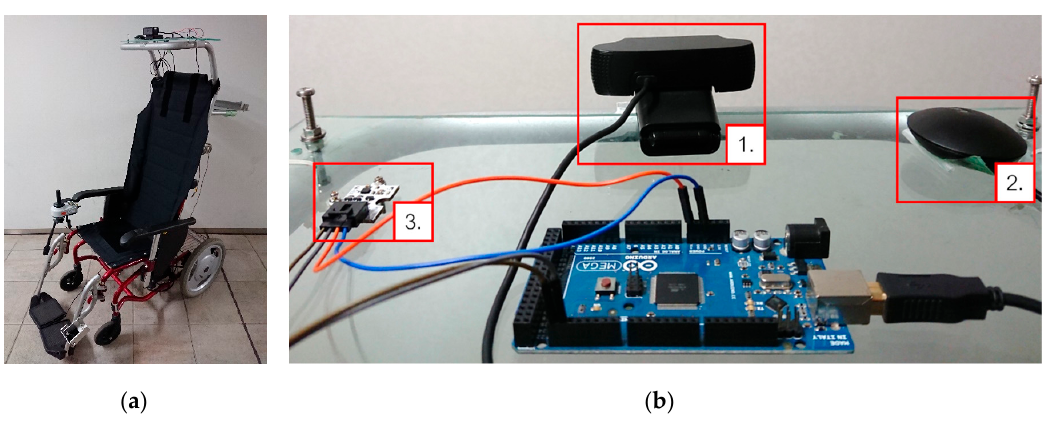
Figure 5. Wheelchair robot equipped with sensors for data gathering: ( a ) overall view of the wheelchair robot; ( b ) sensors for data gathering: 1. Camera, 2. Global Positioning Systems (GPS) receiver, and 3. Compass sensor.